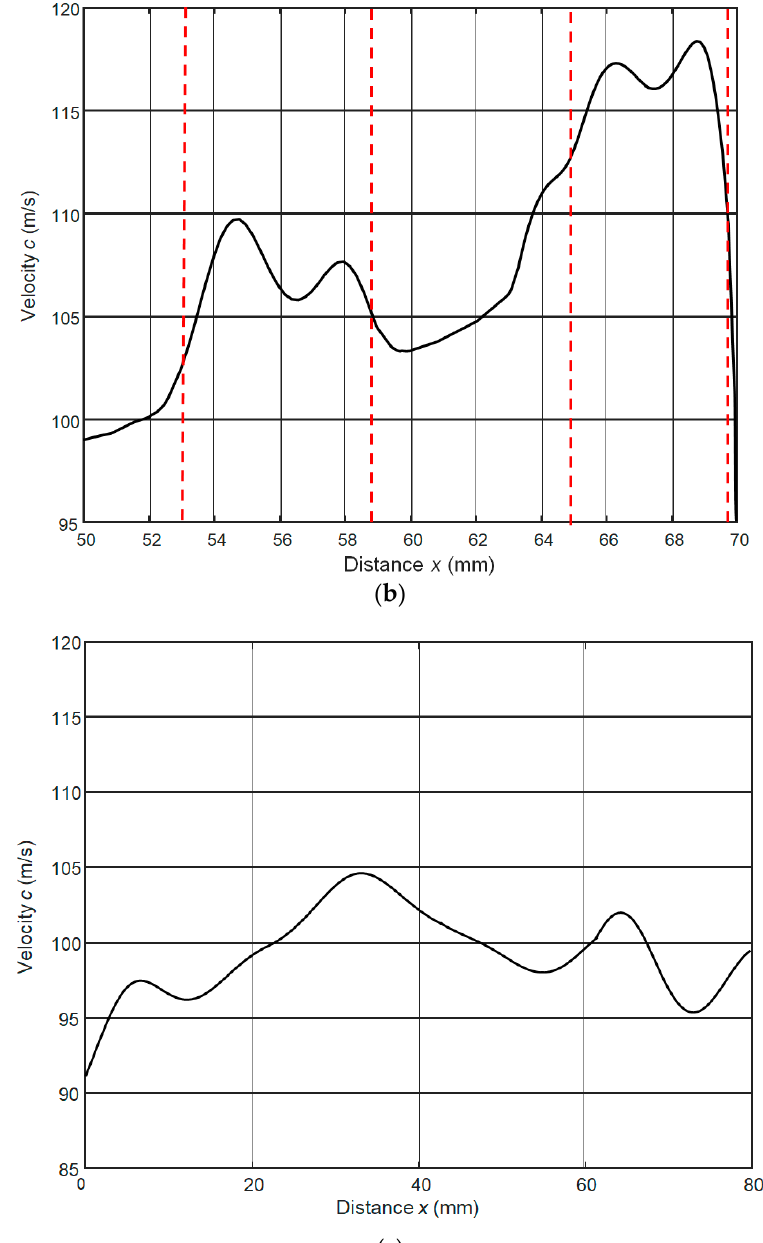
Figure 16. The reconstructed spatial distributions of the A 0 mode phase velocities along x axis in the case of the multiple circular non-uniformities: Figure 12, x = 13–23 mm at y = 0 mm—( a ); Figure 12, x = 50–70 mm at y = 0 mm—( b ); Figure 12, x = 0–80 mm at y = 3 mm—( c ).